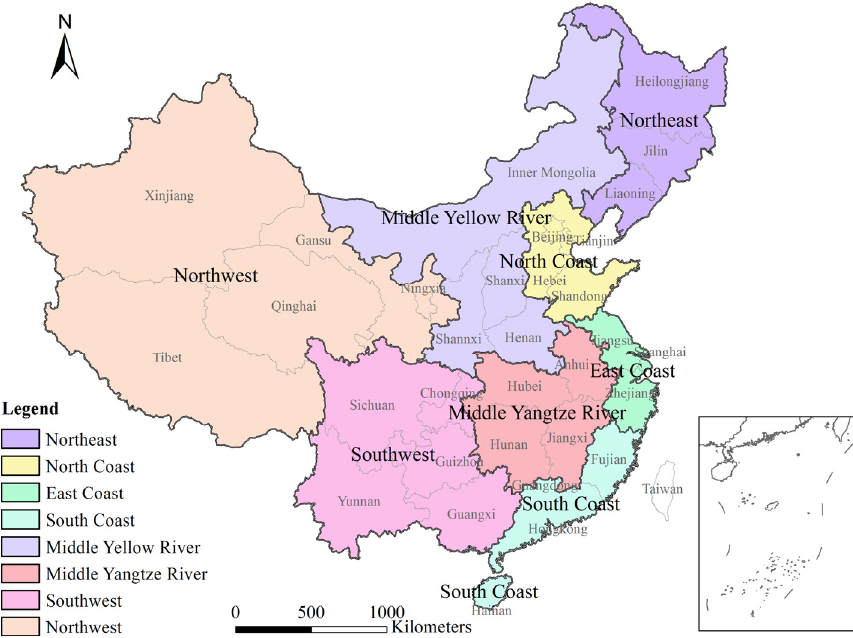
Figure 1. Division of the eight zones in